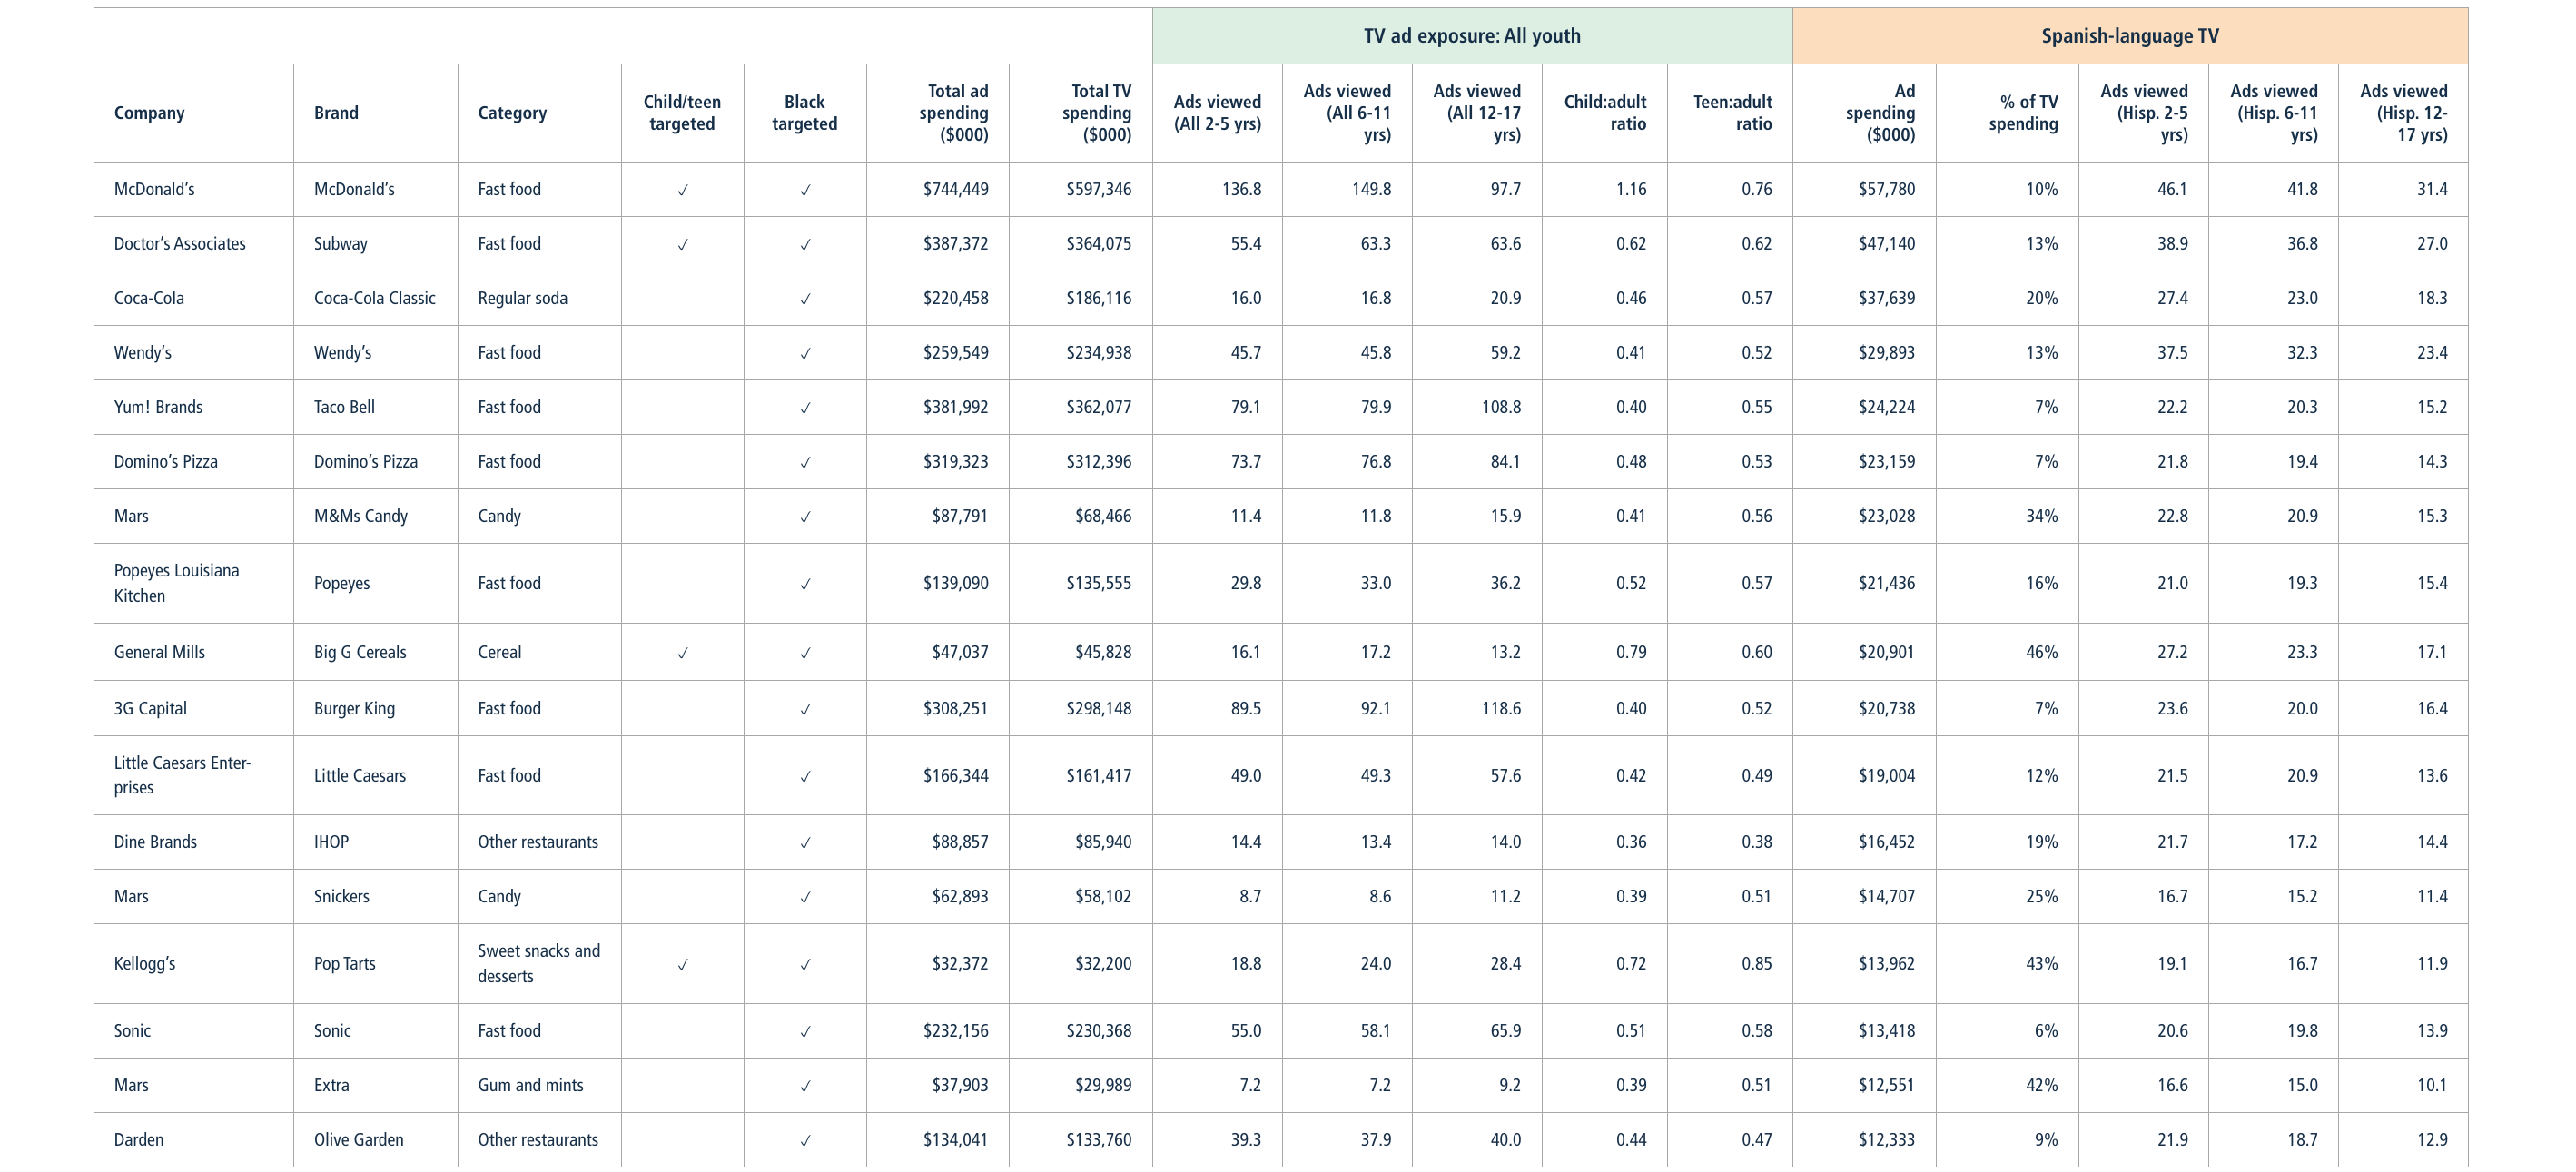
TABLE 2. BRANDS TARGETED TO HISPANIC